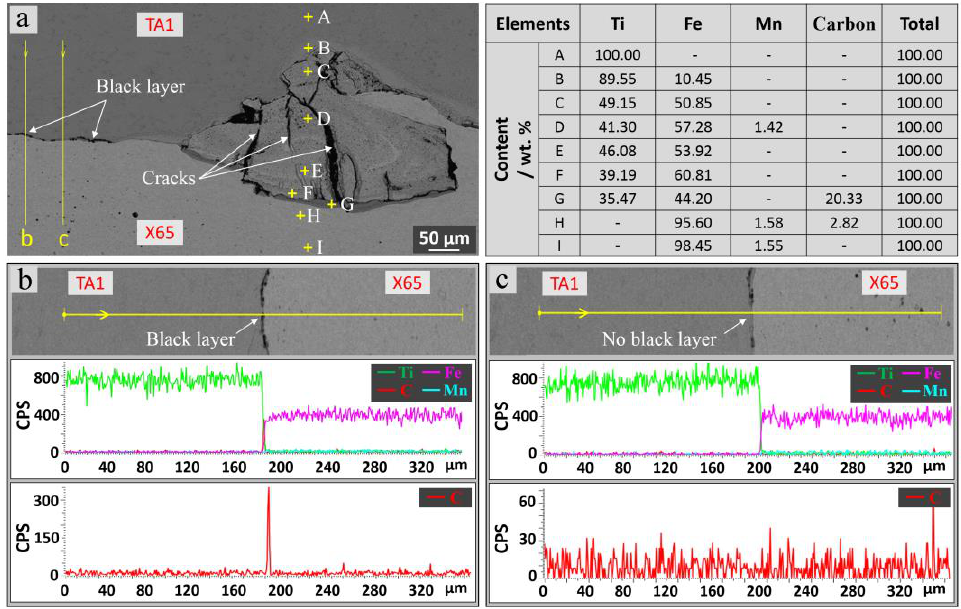
Figure 6. The distribution of elements at the interface of the TA1/X65 clad plate: ( a ) points and lines; ( b ) black layer; and ( c ) no black layer.